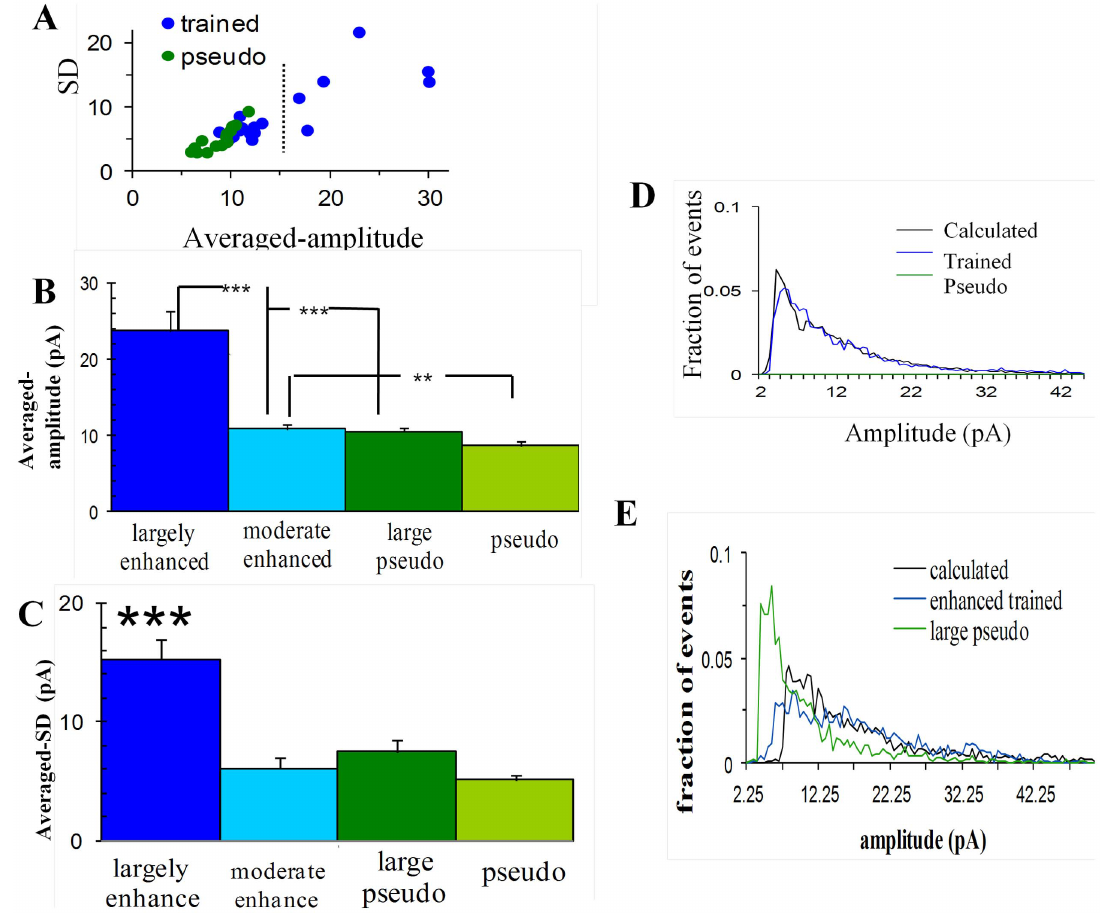
Figure 2. In a sub-group of cells from trained rats ’ amplitudes of all excitatory miniature events is doubled. A. Each cell was plotted as a function of its averaged event amplitude and standard deviation. Few cells from trained-group had exceptionally large averaged amplitudes and Standard-deviations. Using hierarchical clustering analysis the cells were divided to two groups (separated by the dotted line). B. The averaged amplitude of the greatly-enhanced-trained-group only is doubled to a value that is significantly higher than that observed for the three other represented sub-groups. Note that while the average amplitude of the moderately enhanced group is significantly lower than that of the greatly enhanced group, it is still higher that the averaged amplitude of the pseudo trained group. Values represent mean 6 SE (**, p , 0.01 ***, p , 0.001). C. The standard deviation of the greatly-enhanced-trained-group is also doubled, compared to the other three sub-groups, which have all similar values. Values represent mean 6 SE, (***, p , 0.001). D. The distribution curve describing the trained neurons can be constructed from the events amplitudes of the pseudo-trained neurons. The expected curve (black) calculated from pseudo events (green) overlaps (r=0.96) the trained distribution curve (blue). E. The distribution curve describing the greatly-enhanced trained neurons can be constructed from the events amplitudes of the large pseudo-trained neurons. The expected curve (black) calculated from events of the 4 biggest cells in the pseudo group (green) is similar to the averaged distribution curve of the greatly-enhanced-trained group (blue). (r=0.73, both in D and in E only amplitudes . 7pA were used, since at lower amplitudes, multiplication factors bigger than two requires unavailable data in amplitudes , 3pA, see Methods).